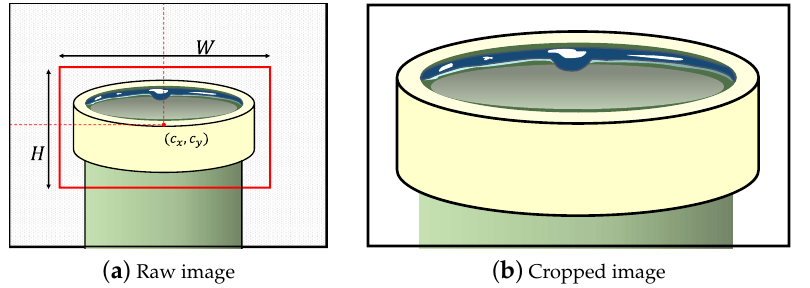
Figure 3. Example of ROI selection: ( a ) raw image, where the shaded area denotes a background region, the solid line denotes a product, and the red box denotes a ROI; ( b ) cropped image according to